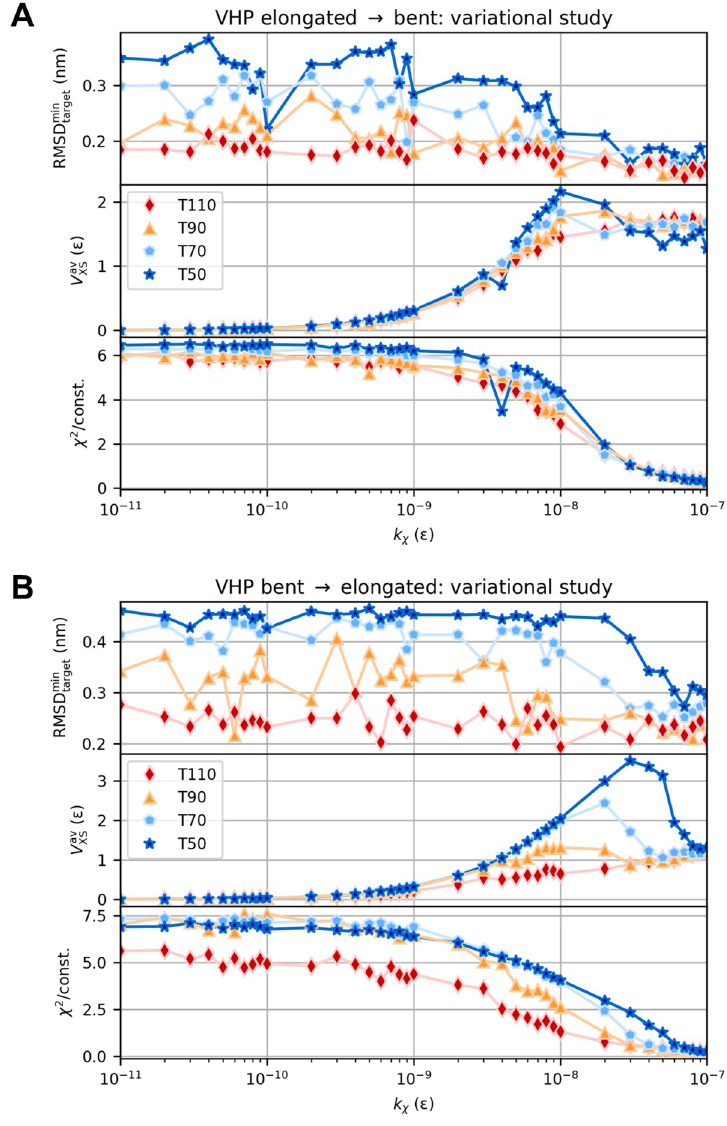
Fig 5. Variational study for VHP-based test system. Minimum target RMSD, average bias energy, and average χ 2 dissimilarity for elongated-to-bent (A) and bent-to-elongated (B) transition as a function of coupling strength k χ at different temperatures T . The variational series comprised 296 simulations in